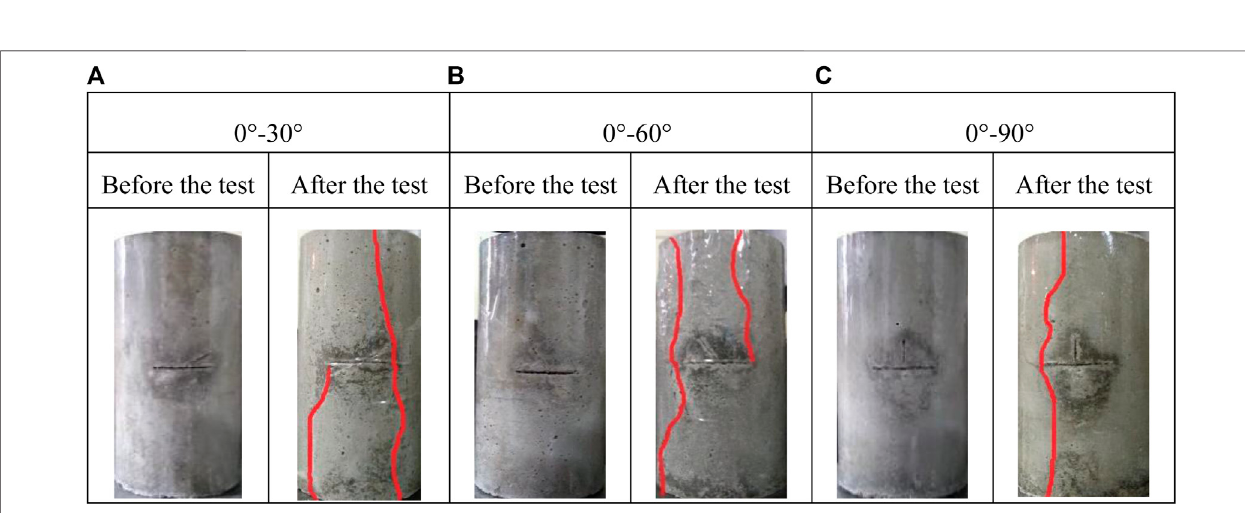
Frontiers in Earth Science |